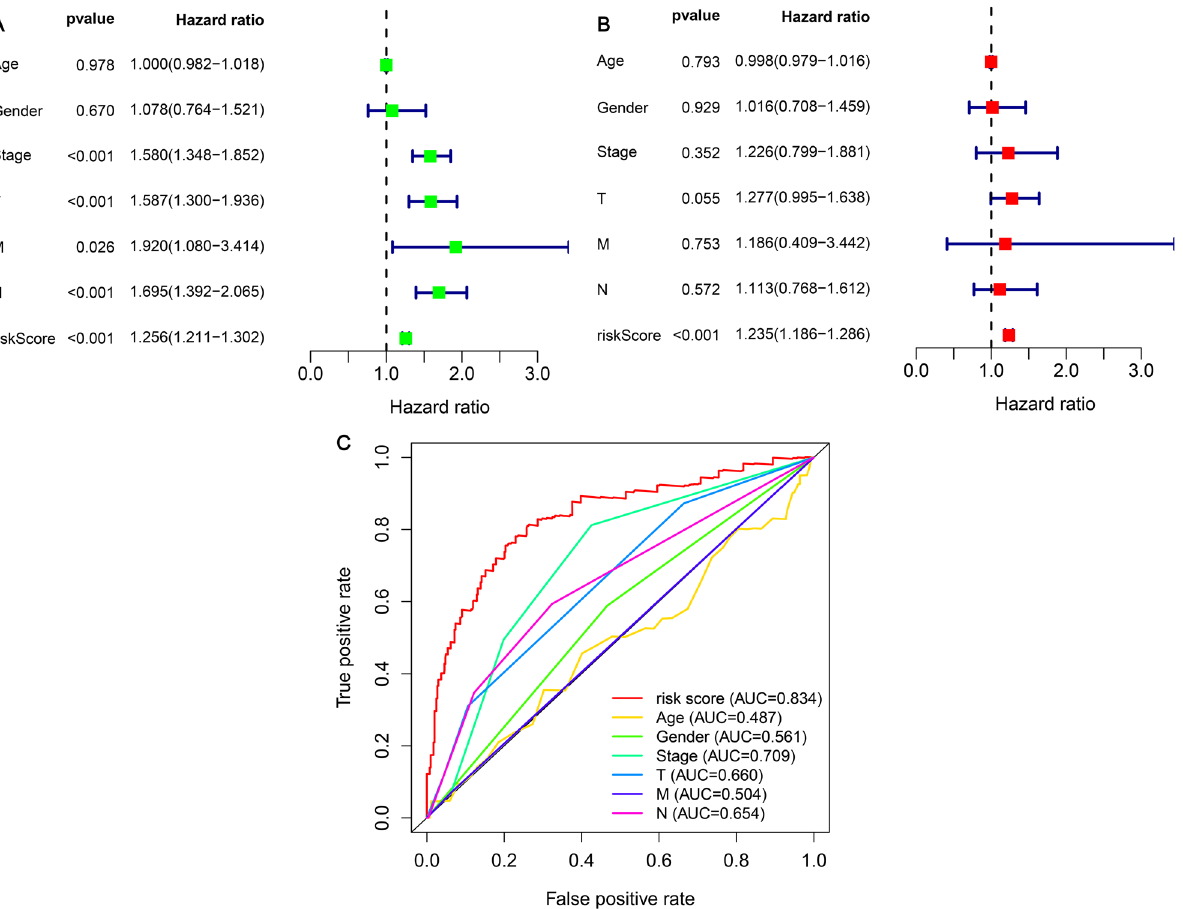
Figure 7. Cox regression analysis of clinical correlation characteristics and integrated ROC curves. ( A ) Clinical characteristics of Cox univariate regression analysis indicated that Stage, T stage, M stage, N stage, and risk score were correlated with the outcome of LUAD. ( B ) Cox multivariate analysis showed that risk scores were predictors of outcome in an independent manner. ( C ) The comparison of risk coefficient score and clinical characteristics showed that Stage (AUC = 0.709) and risk coefficient score (AUC = 0.834) had the highest predictive